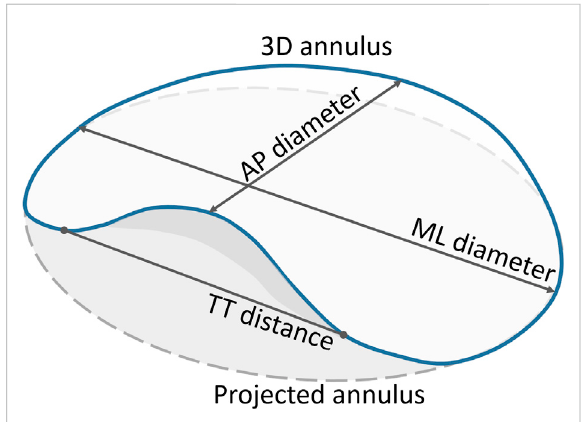
curve represents the 3D saddle-shaped annulus, whereas the grey dashed curve represents the projection of the mitral annulus onto its best- fi t plane. Both the 3D and the projected 2D perimeters were measured. Only the grey area, corresponding to the projected curve, was calculated. The two main diameters, namelythe AP and ML diameters, were measured based on the 3D annulus curve. The TT distance was measured in 3D, with the TT- line replacing the anterior portion of the saddle-shaped curve to represent the D-shaped